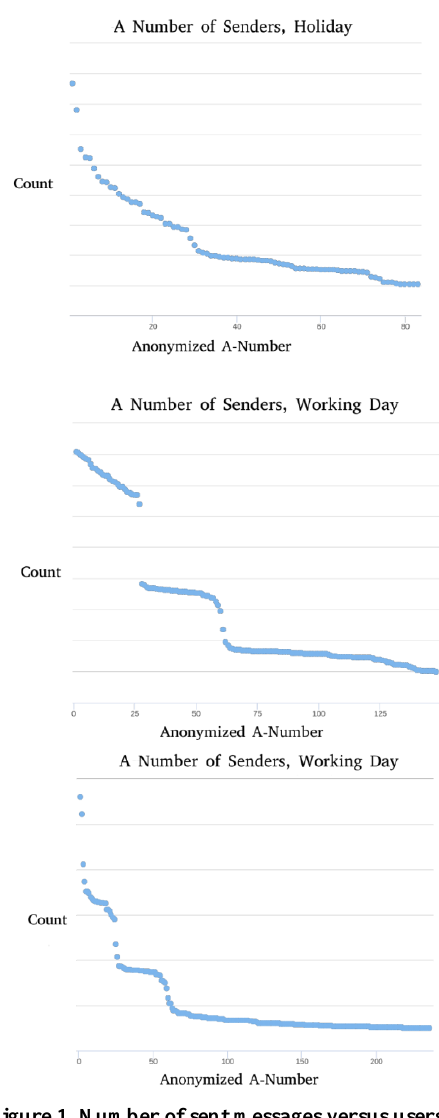
Figure 1. Number of sent messages versus users' anonymized